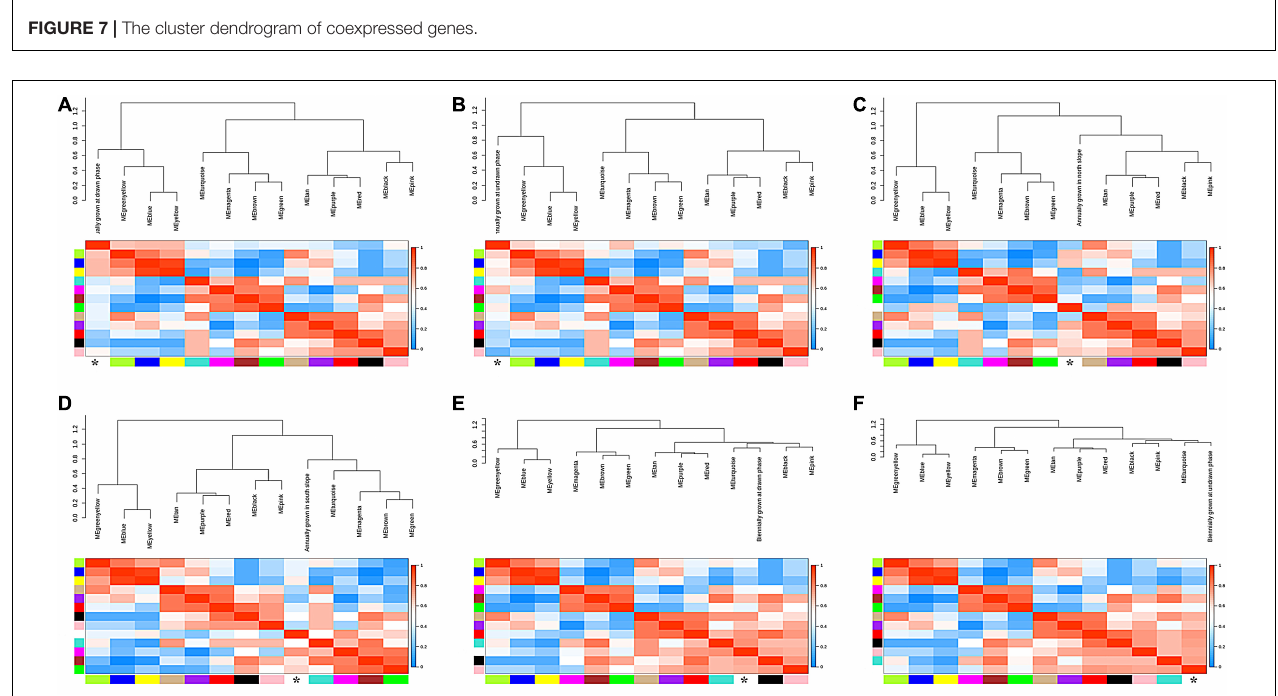
FIGURE 8 | The eigengene adjacency trees of different conditions. (A) Annually grown at drawn phase. (B) Annually grown at undrawn phase. (C) Annually grown in north slope. (D) Annually grown in south slope. (E) Biennially grown at drawn phase. (F) Biennially grown at undrawn